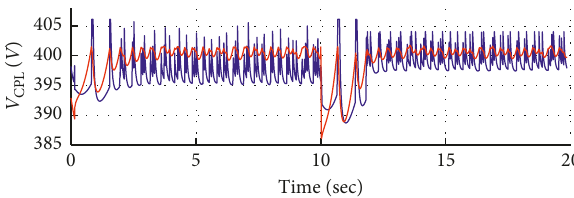
Figure 6: The voltage of the DC bus (the proposed approach by the red line and the sliding mode approach by the blue line).